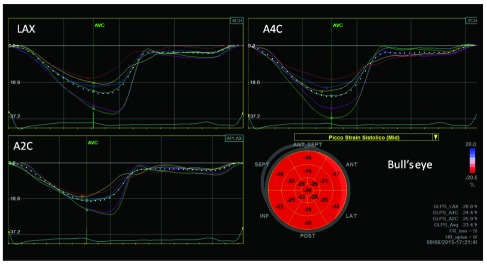
Automated function imaging (AFI) of left ventricular 2-D strain of endurance athlete, showing normal longitudinal regional myocardial deformation despite left ventricular hypertrophy (arrows) (LAX: long-axis view; A4C: apical four- and A2C apical two-chamber views).Bull’s eye represents in a single image all myocardial regional deformations, from basal, to middle and apical segments.